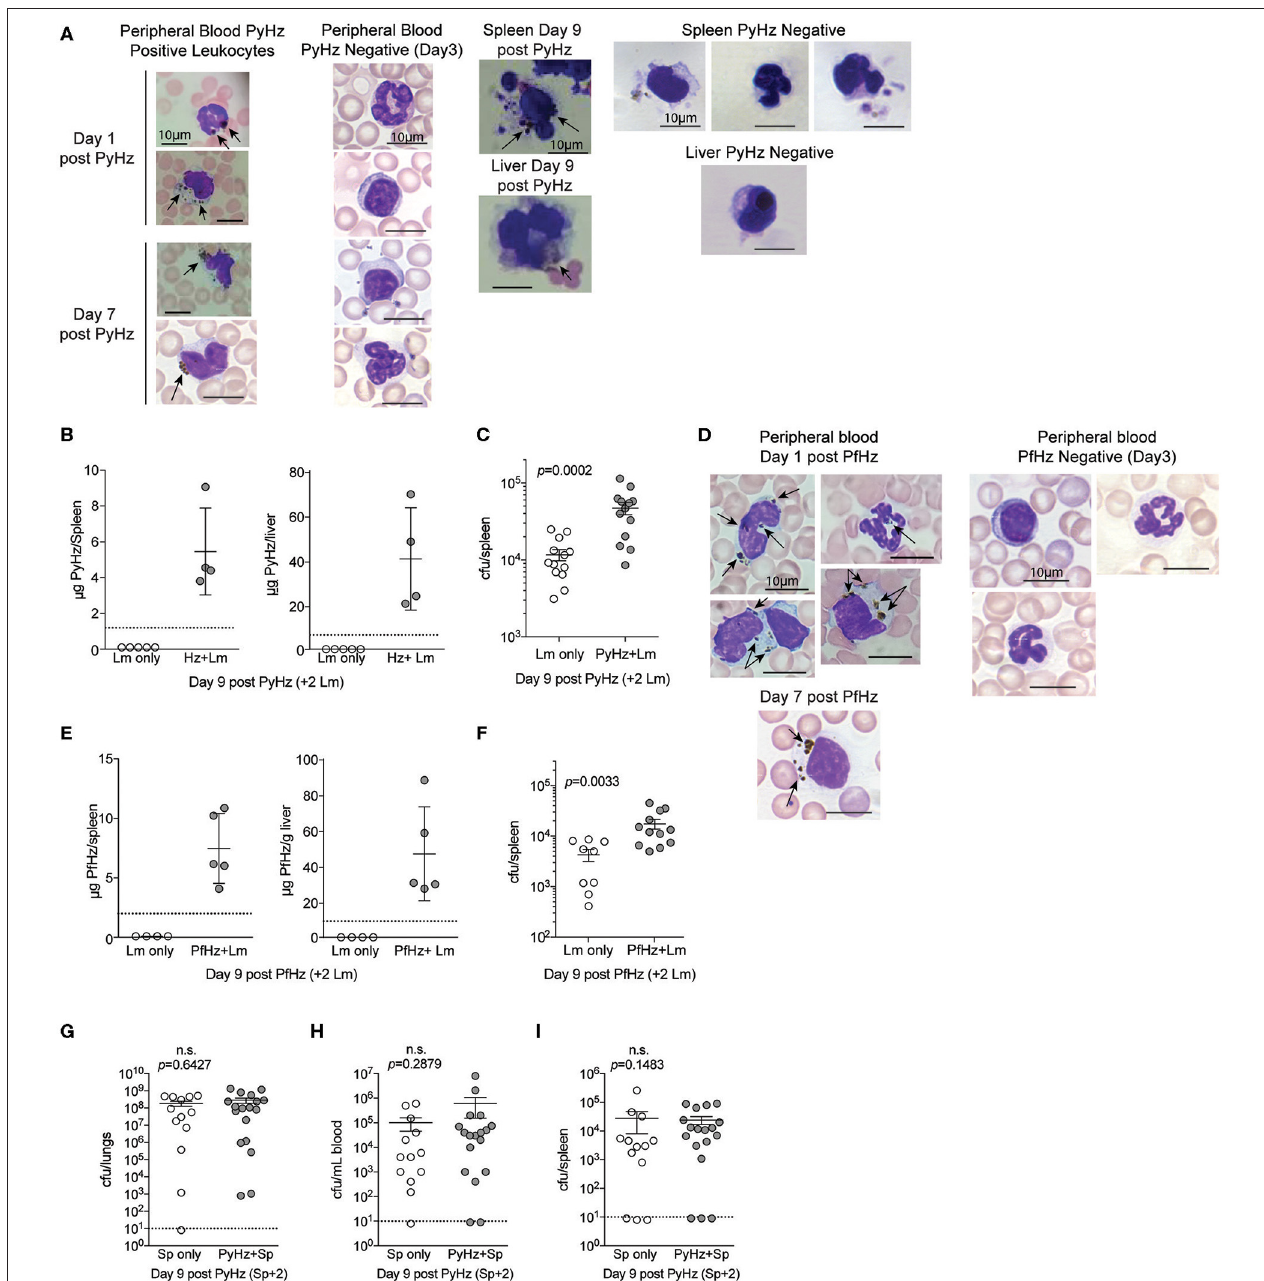
FIGURE 8 | Hemozoin with bound biomolecules is sufficient to impair clearance of Lm in vivo. C57BL/6N mice treated i.v. with 1mg PyHz isolated from livers and spleens of Py infected mice (A–C) or hemozoin isolated from P. falciparum (Pf) infected red blood cell culture (PfHz) (D–F) . Seven days after Hz treatment mice were infected with 5 × 10 6 CFUs Lm. (A,D) Giemsa stained peripheral blood smears and cells mounted from spleen and liver single cell suspensions on the indicated days post Hz treatment. Arrows indicate the presence of intracellular Hz, visible as brown pigment. PyHz and PfHz-negative leukocytes were present at indicated time points in peripheral blood, spleen or liver with no visible intracellular Hz pigment (B,E) . Quantification of Hz in spleens and livers. Data (mean ± S.D.) are from a single experiment representing three independent experiments. Dotted lines represent the limit of Hz detection. Bacterial burden in spleens of PyHz (C) , PfHz (F) or untreated control mice was determined 2 days post Lm infection. Data (mean ± S.E.) are cumulative results from 2 to 3 independent experiments. Each symbol represents an individual mouse. (G–I) C57BL/6N mice were treated i.v. with 1–1.5mg PyHz followed by i.n. infection with 10 6 CFU Sp 7 days later. Mice were sacrificed 2 days after Sp infection and lungs, blood, and spleens were collected for bacterial burden analysis. Data (mean ± S.E.) are pooled results from three independent experiments. For all data, each symbol represents an individual mouse. Statistical significance was determined with Mann-Whitney test.